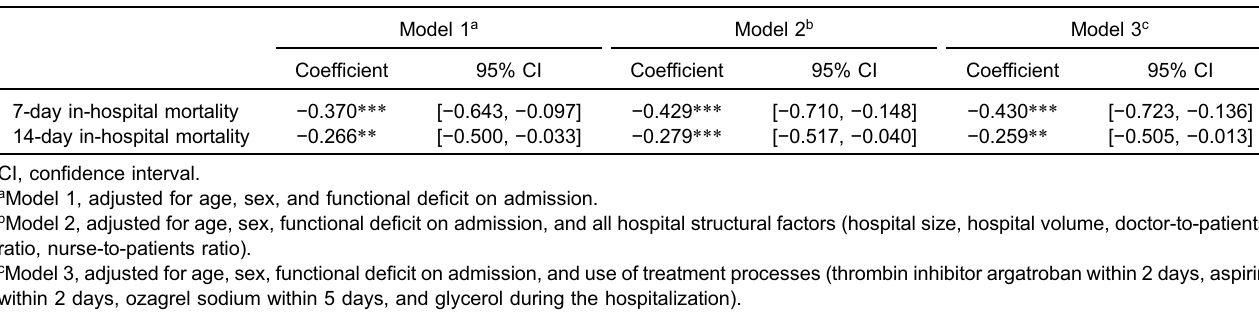
Table 4. Effect of certi fi ed hospital admission on mortality by instrument variable method, adjusting for hospital characteristics and treatment